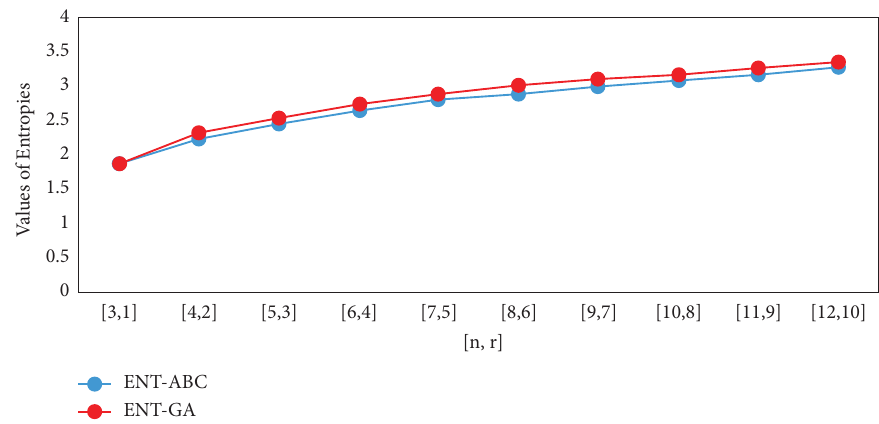
Figure 6: Comparison of atom bond connectivity entropy and geometric arithmetic